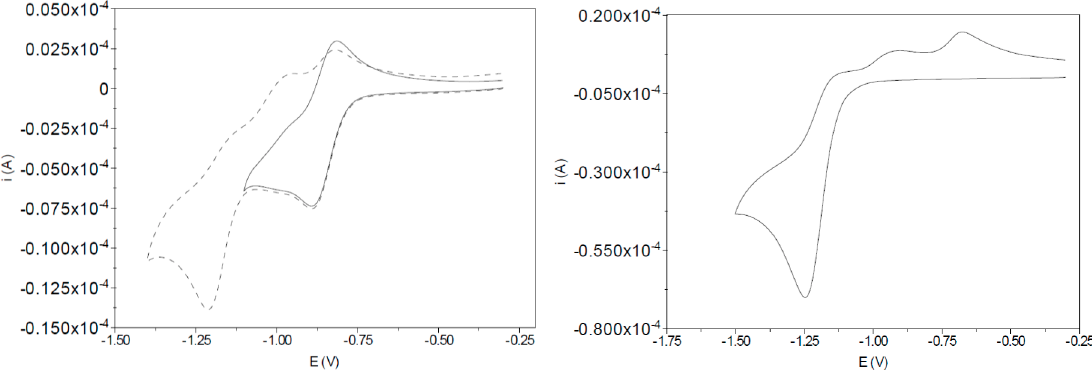
Figure 1. Cyclic voltammogram of ( left ) I-bzNO 2 (2 mM, 0.2 M [NBu 4 ][BF 4 ] in CH 3 CN, 0.1 V·s − 1 ) and ( right ) I-bzNH 2 (7 mM, 0.2 M [NBu 4 ][BF 4 ] in CH 3 CN, 0.1 V·s − 1 ). The cyclic voltammograms of nitrobenzene and CH 3 C(CH 2 S) 2 CH 2 S(C 6 H 4 - p -NO 2 ) recorded under the same experimental conditions